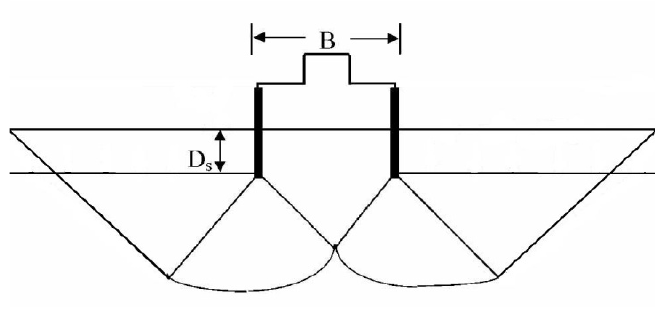
Fig. 1. Slip lines length increasing of ring